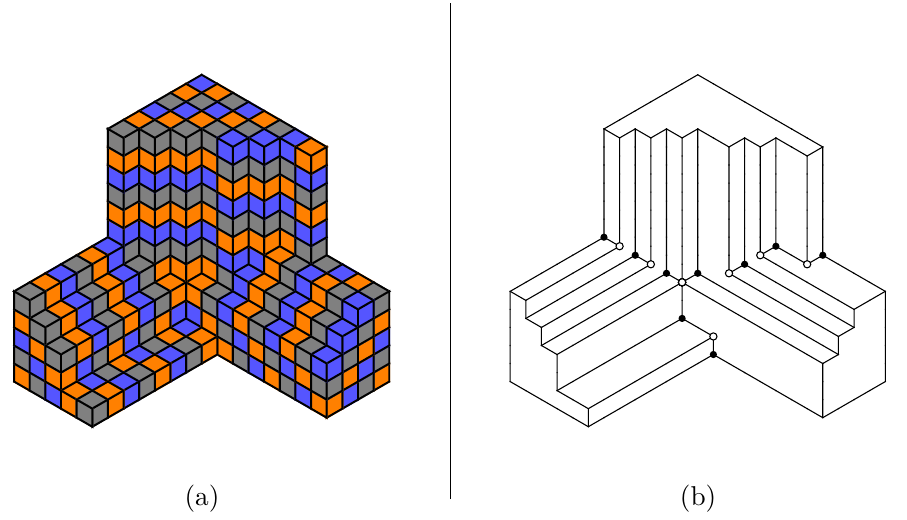
subcrystal given by the asymptotics Y Figure 11 . A K P 2 Y 3 = { 8 , 6 , 5 , 3 , 2 , 1 } : (a) the ground state configuration and (b) the graph D ~